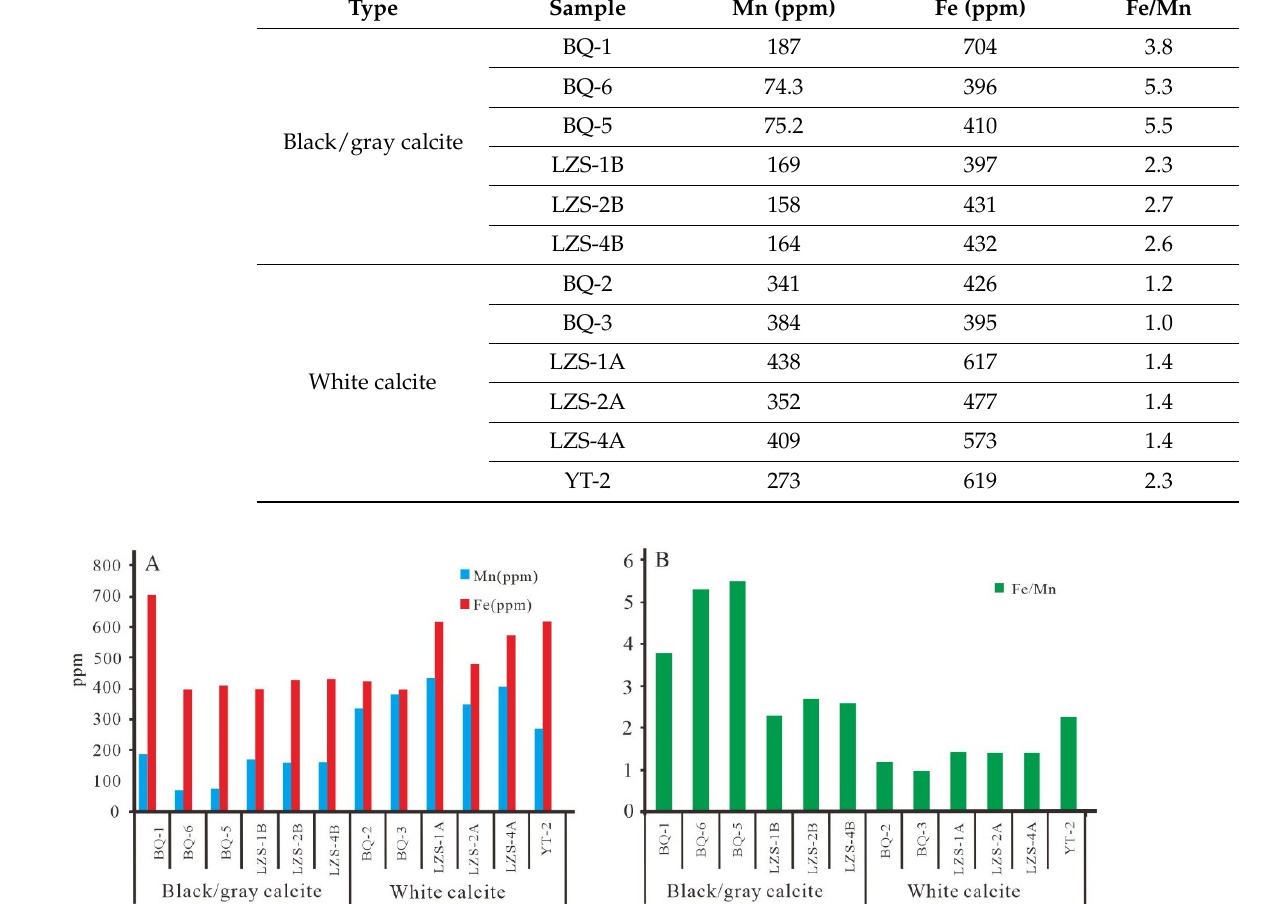
Figure 6. Histogram of Fe and Mn content of calcite in the Banqi-Yata-Laiizishan area. ( A ) the abundance of the Fe and Mn in the calcite samples. ( B ) The ratio of Fe/Mn for the calcite samples